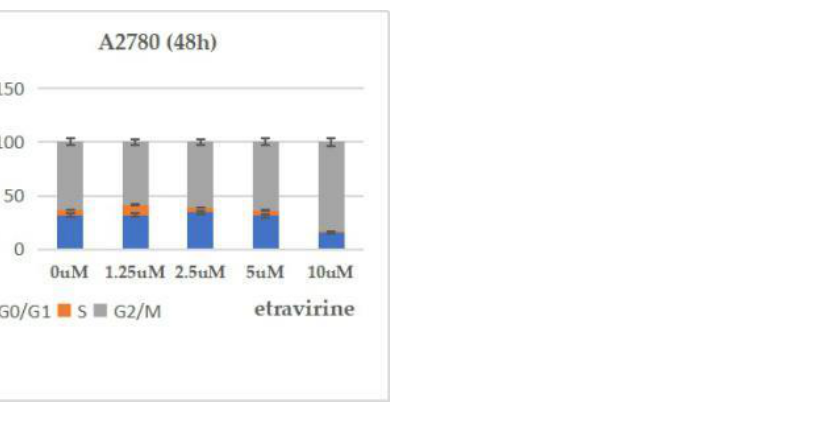
indicated concentrations for seven days. As shown in Figure 3, etravirine significantly di- minished spheroid formation.